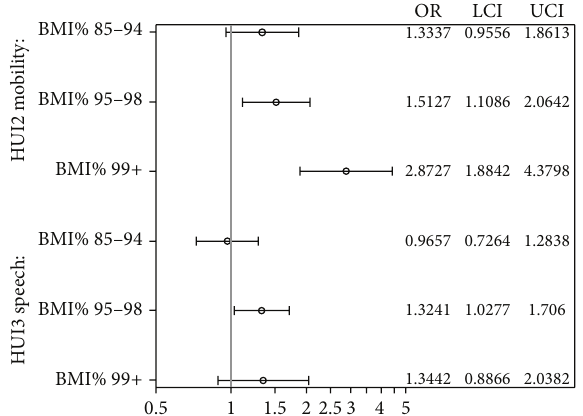
Figure 1: Odds ratios by level of Health Utility Index functioning for BMI category compared with normal weight, adjusted for gender, race/ethnicity, tanner stage, household education, and insulin.